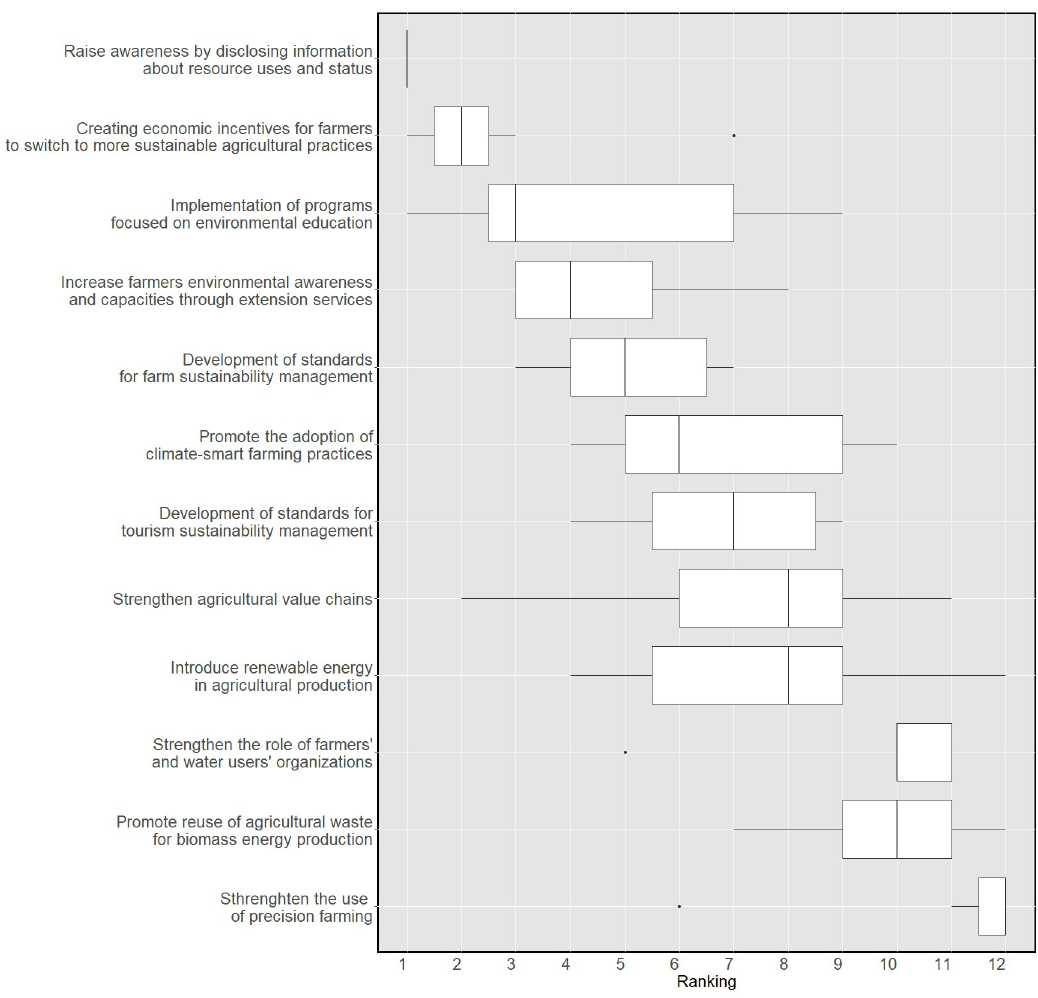
Fig 6. Prioritisation of governance and policy responses. Experts’ ranking on a scale from 1 to 12 (KW: 0.43).